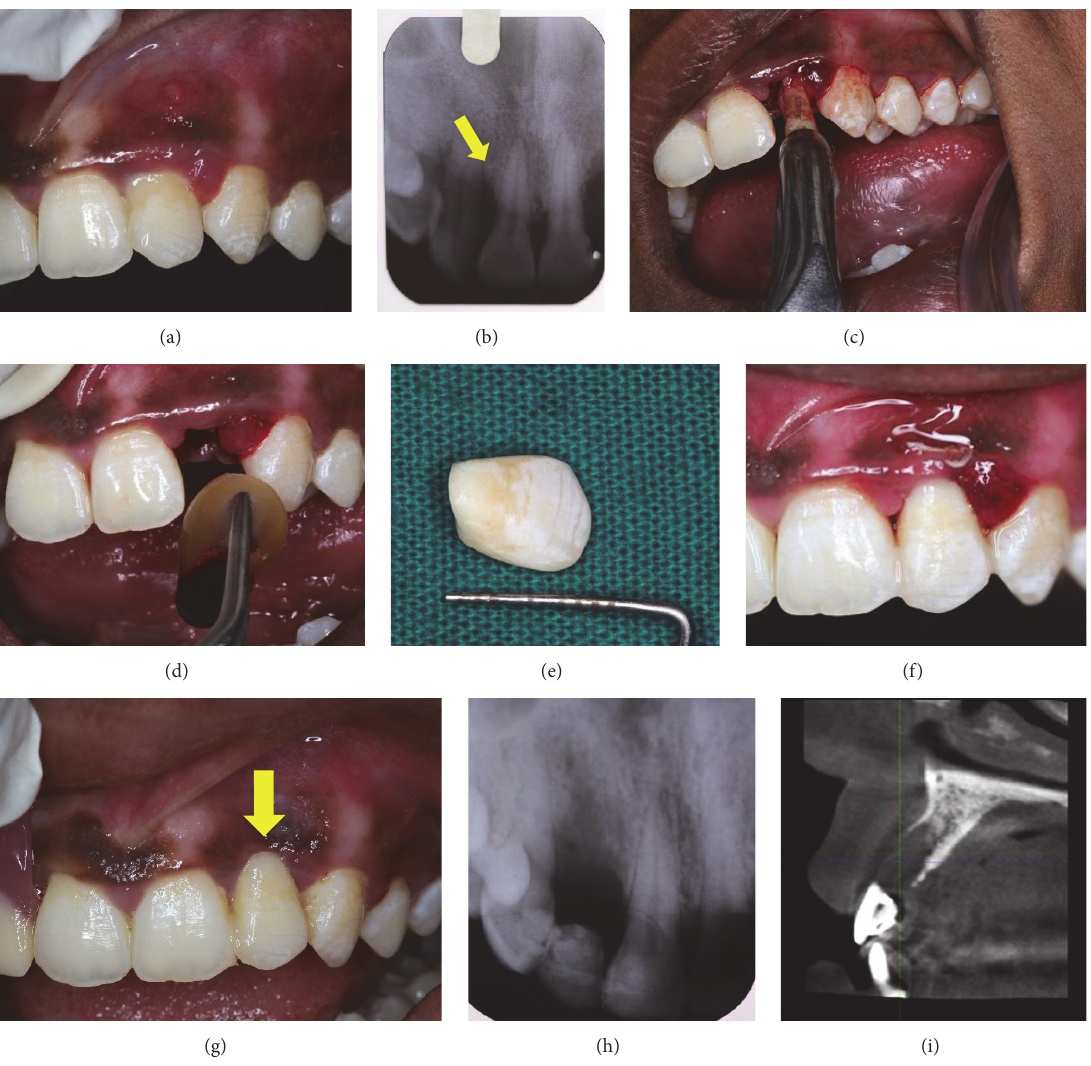
Figure 1: (a) Preoperative. (b) Preoperative radiograph. (c) Extraction of 22. (d) Insertion of PRF. (e) Customized NTP. (f) Immediate postoperative. (g) 1 week postoperatively. (h) 1 week postoperatively. (i) CBCT NTP with respect to